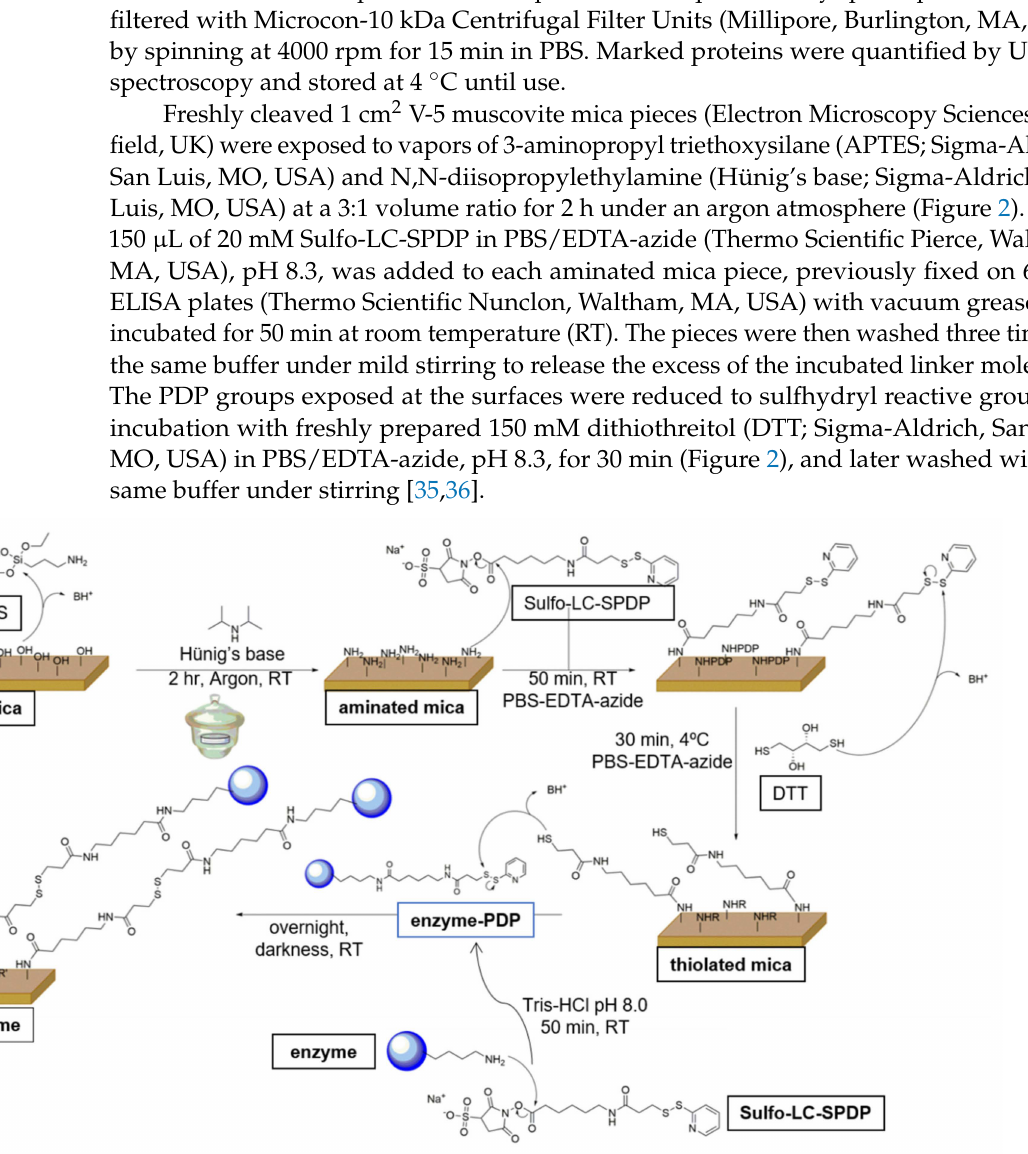
Figure 2. Procedure followed for the covalent immobilization of FNR on mica pieces. Mica